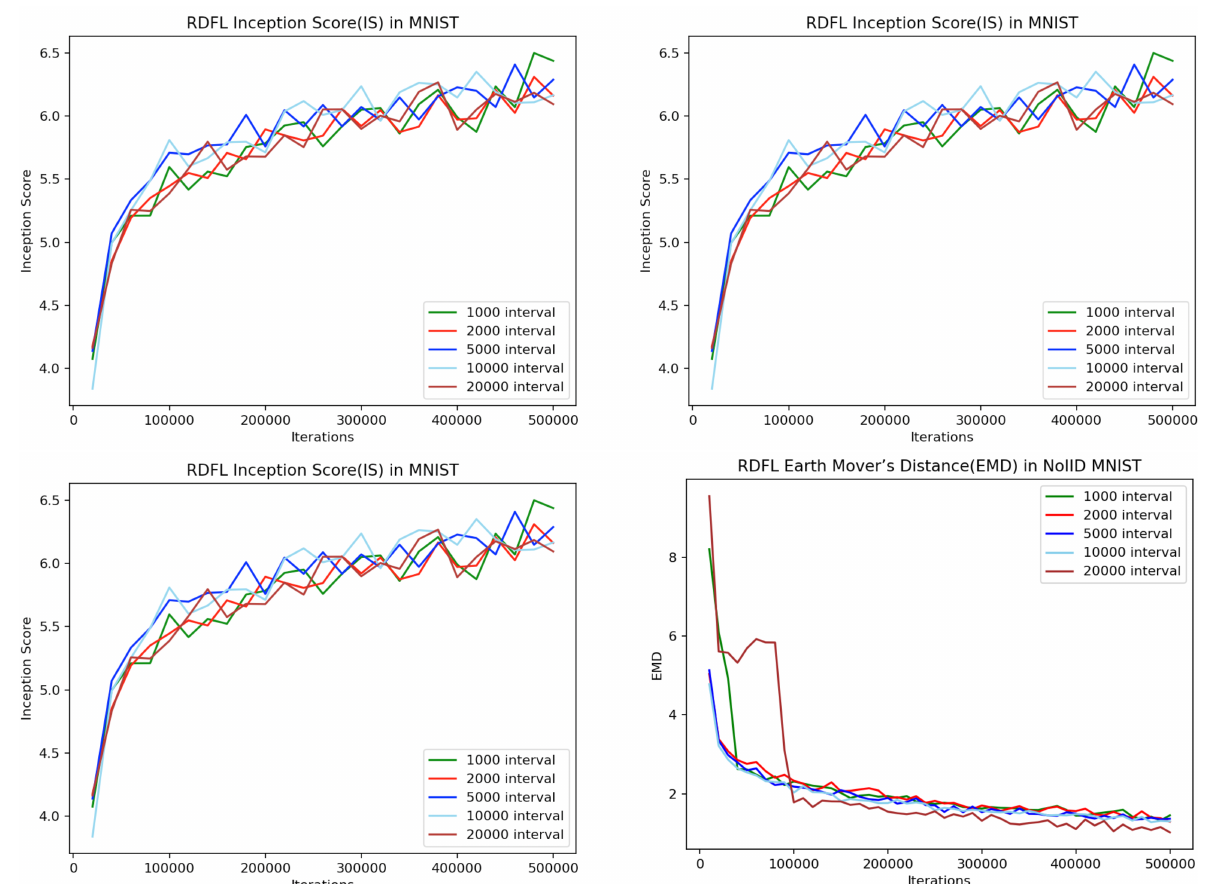
Figure 6. Illustration of FL training quality with GAN on MNIST IID ( left ) and non-IID ( right ), where number of nodes B = 5. ( left ) Generated images on K = 2000, ( middle ) IS vs. Iterations with K ∈ [1000, 2000, 5000, 10,000, 20,000], ( right ) EMD vs. Iterations with K ∈ [1000, 2000, 5000, 10,000,